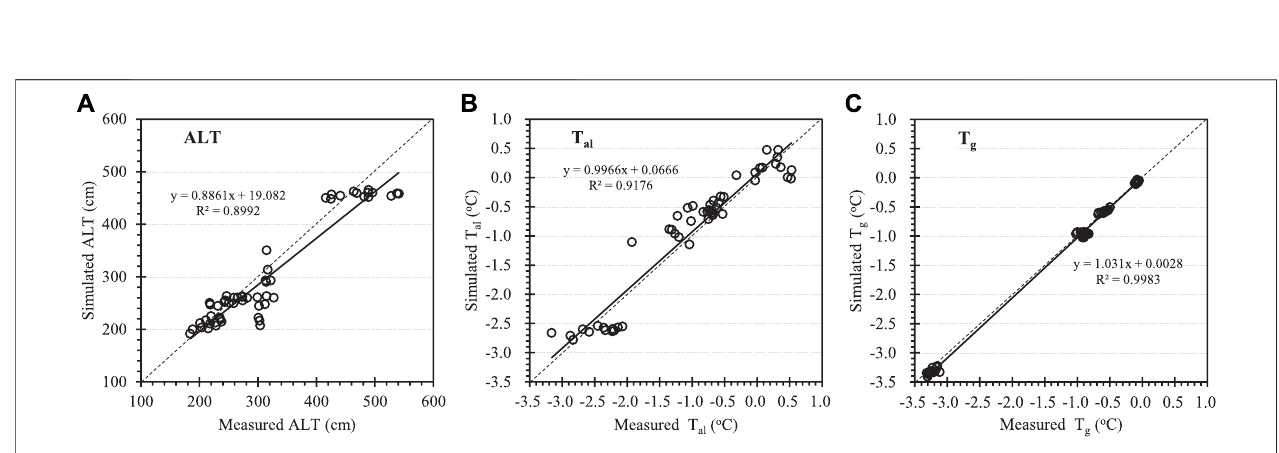
FIGURE9| Comparison betweenthe measured and simulatedvalues inoneofboreholeat the foursites. (A) Relationship ofthemeasured and simulatedALT, (B) annual mean T al , and (C) annual mean T g .